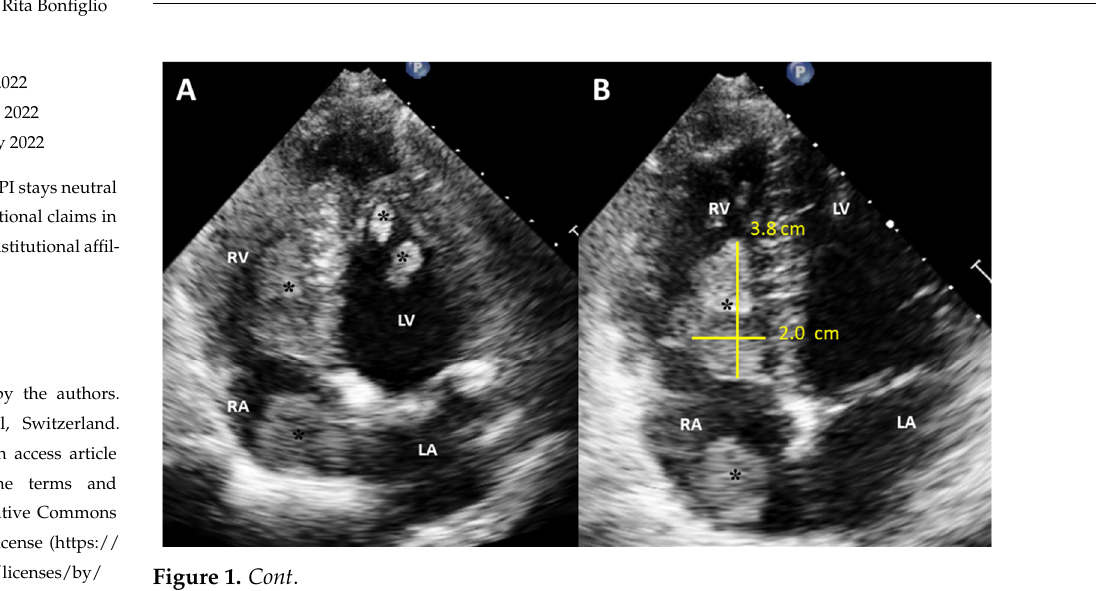
Figure 1. Initial scan : Transthoracic echocardiogram images, four chamber apical view ( A , B ) and parasternal long axis view ( C , D ). Multiple masses in the cardiac chambers are marked with black asterisks. A 30-year-old Caucasian man with a history of an in-situ melanoma of the forehead, which was surgically excised four years earlier, was referred for cardiac evaluation because of tachycardia and elevated levels of serum troponin. The patient had presented three months ago to the oncology clinic, with dry cough and pigmented skin nodules on the left shoulder, left forearm, chest, and forehead. Abdominal and brain computed tomography (CT) scans showed several metastatic lesions in the liver, the spleen, and the brain, while the histologic evaluation of one of the skin lesions revealed metastatic melanoma. Being BRAF-unmutated, the patient was initially treated with a combination of nivolumab and ipilimumab but due to grade 3 colitis, the treatment was replaced by a combination of dacarbazine and carboplatin. During clinical examination he was hemodynamically stable and his electrocardiogram showed sinus tachycardia at 120 beats per minute. The echocardiogram revealed multiple masses attached to the walls of both ventricles and the right atrium (RA) while no mass was detected in the left atrium (LA) ( A ). A large intracavitary mass (3.8 cm × 2.0 cm) was occupying almost one third of the right ventricle (RV) while a lobular right atrial nodule (2.4 cm × 2.2 cm) was attached to the posterior wall of the RA by a small pe- duncle ( B , C ). Additionally, a small mass in the left ventricle (LV) was attached to the interventric- ular septum ( D ). The end-diastolic RV volume was severely reduced by the mass, resulting in compensatory tachycardia, while there was no significant tricuspid valve inflow obstruction. The biventricular function was mildly reduced. A cardiac magnetic resonance (CMR) imaging con- firmed the multifocal myocardial infiltration and the intracavitary masses and excluded the pres- ence of thrombus in any of the cardiac chambers (Figure 2). Diffuse metastatic involvement pre- cluded surgical management. One month later the cardiac metastases in RA and LV were un- changed on echocardiogram, while the tumor in RV was enlarged occupying the majority of the chamber, resulting in further reduction of the cardiac output and tachycardia (Figure 3, Supple- mental Video S1). The treatment was changed to a combination of dacarbazine and carboplatin, but the patient eventually died two months later. Our case illustrates a rarity of metastasis of a malig- nant melanoma of to the heart providing useful information for doctors in training and practition-